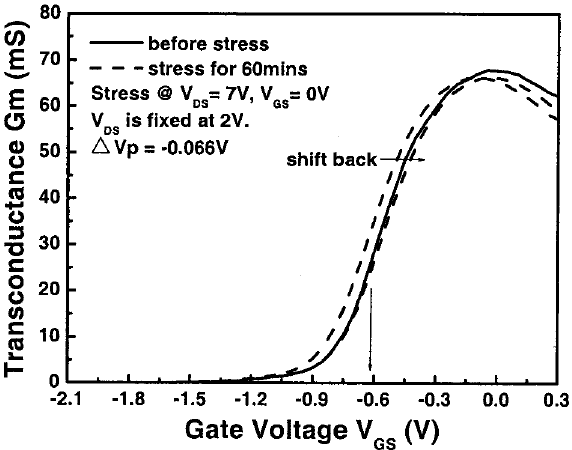
FIGURE 3 The transfer curve of AlGaAs = InGaAs = GaAs PHEMTs before and after stress for 60 minutes at V DS ¼ 7V ; V GS ¼